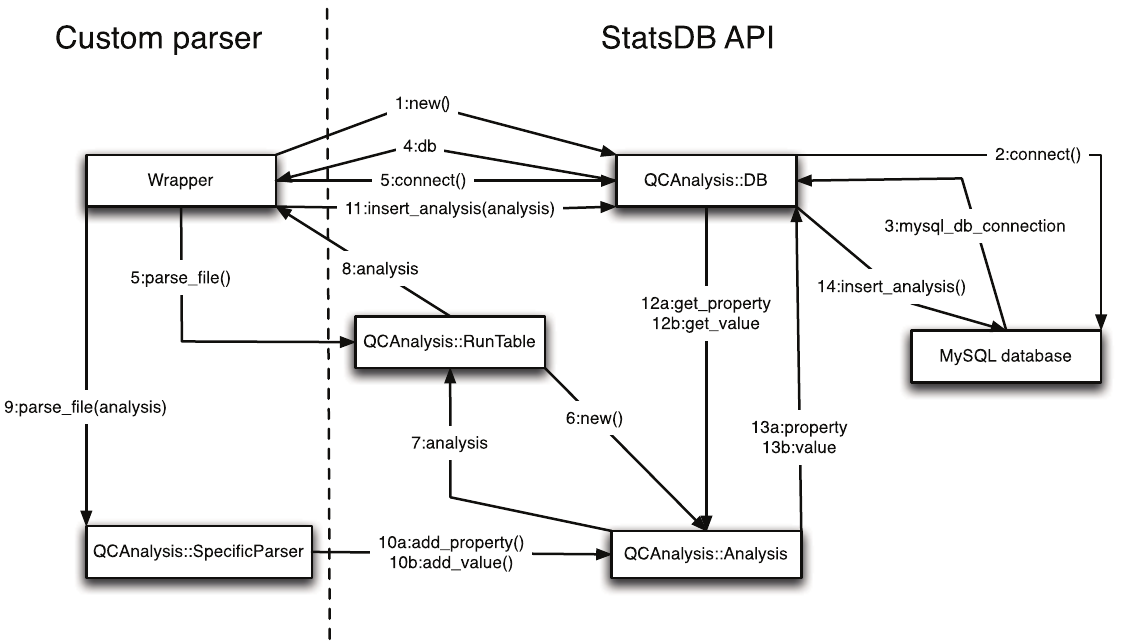
Figure 3. StatsDB parser interaction diagram, using the Perl API. To add new parsers, only the SpecificParser has to be written. The rest of the classes abstract the interaction with the database and ensure the consistency of the data. The Java API utilises different class and method names but employs the same generalised interactions.